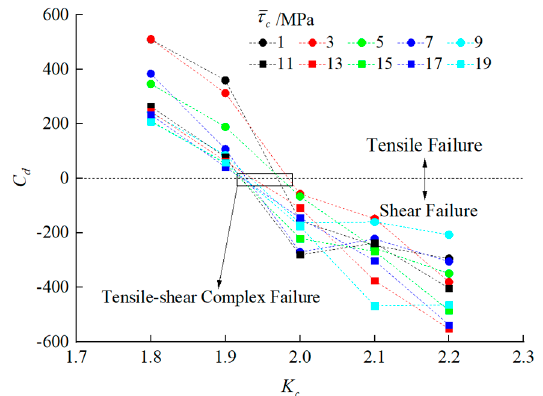
Figure 8. Effects of tensile-shear bond strength ratio on the difference in quantity between tensile and shear cracks.